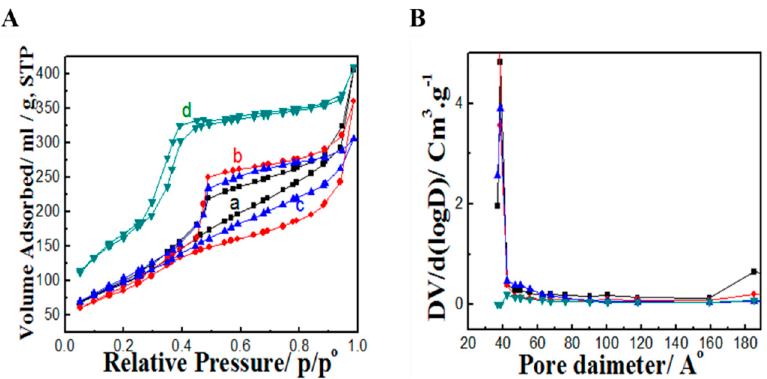
Figure 2. ( A ) N 2 sorption isotherm and ( B ) pore size distribution of MSN-NH 2 prepared with different volumes of APTES: (a) 50 µL, (b) 75 µL, (c) 100 µL, and (d) 150 µL.